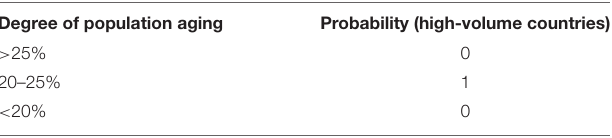
TABLE 7 | Probability of countries with high smart bed sales in different sleep time periods.